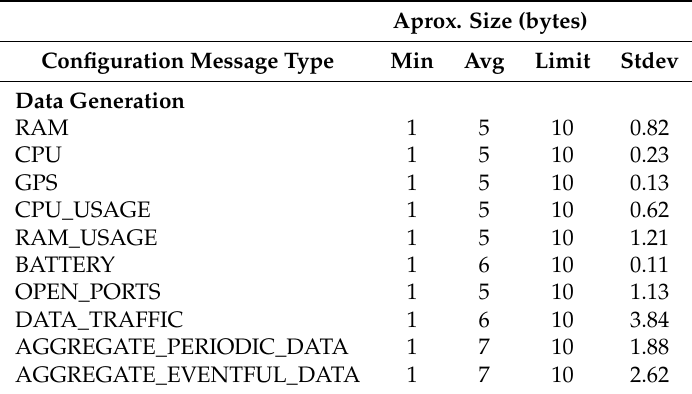
Table 5. Configuration Message Size Analysis—telemetry.